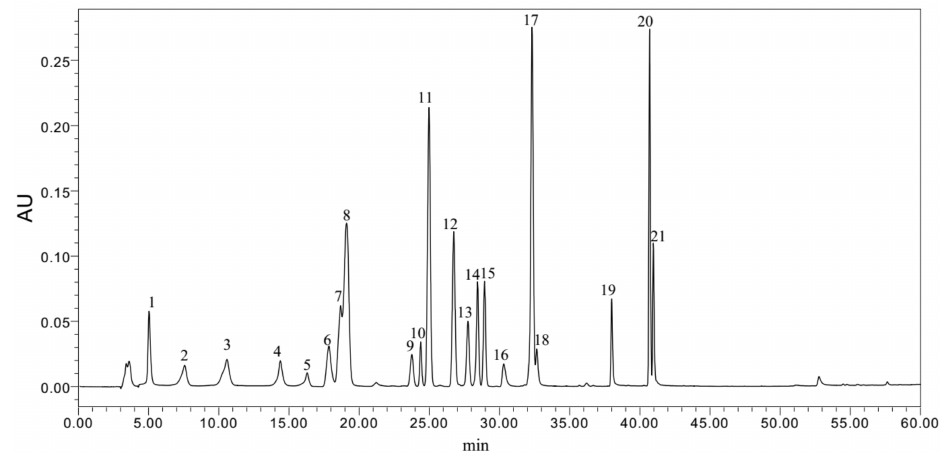
Figure 1. HPLC chromatogram of standards of phenolic compounds. (1) phloroglucinol; (2) gallic